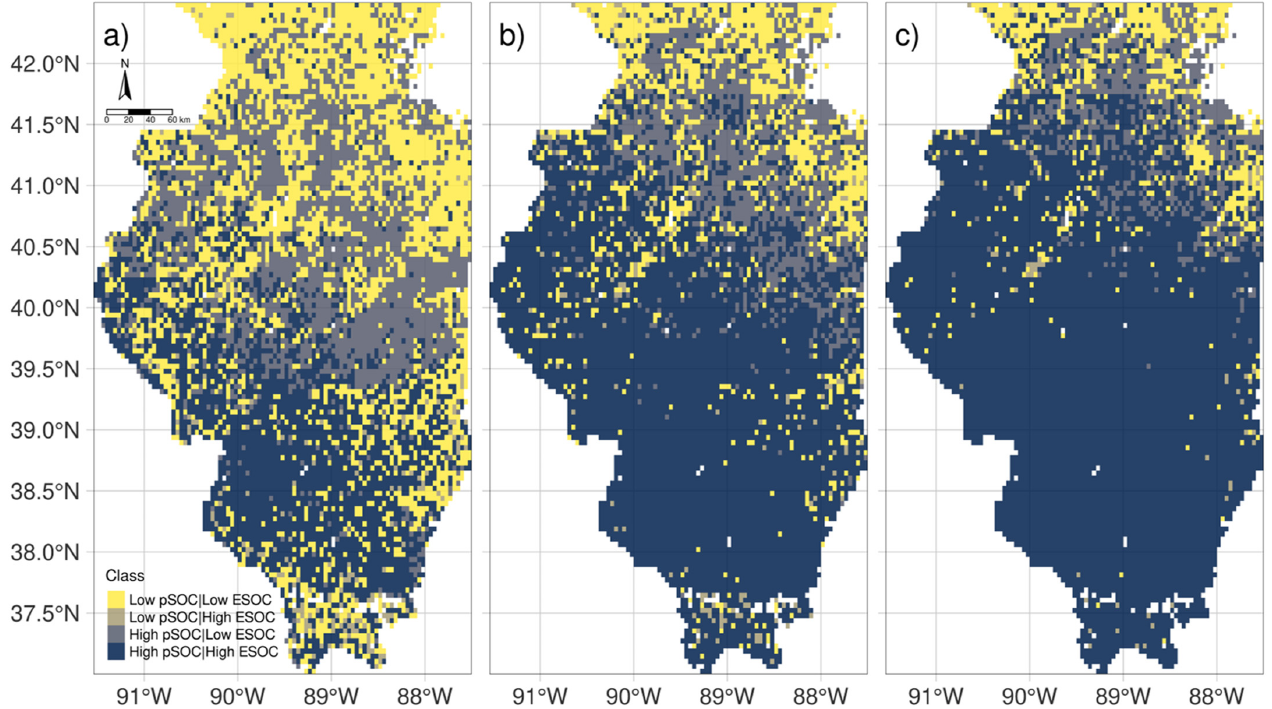
Figure 5. Probability and expected increase in SOC under corn-rye-corn-rye rotation compared with corn rotation in ( a ) 2010, ( b ) 2015, and ( c ) 2020. ESOC > 15% is classified as high and ESOC < 15% is